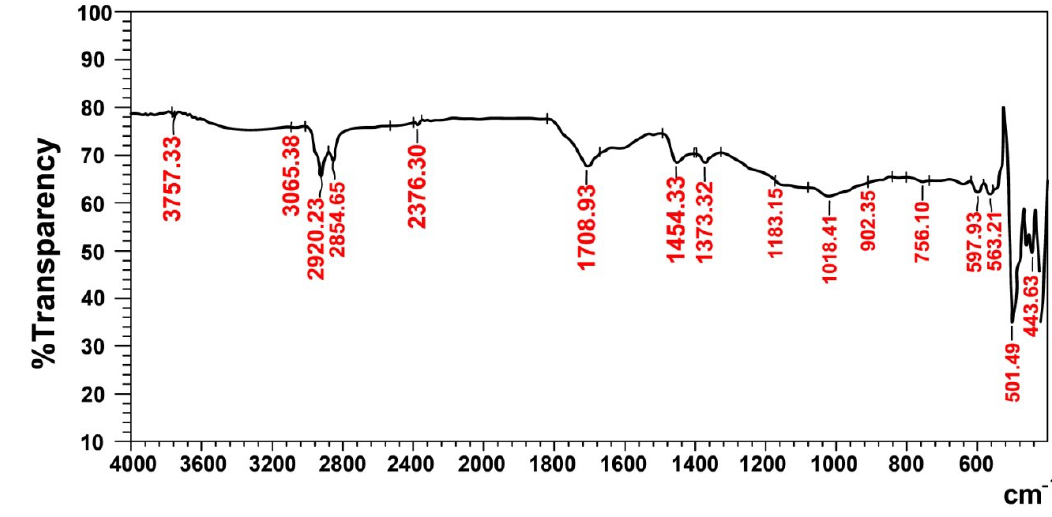
Figure 6. FTIR spectra of recovered rubber.